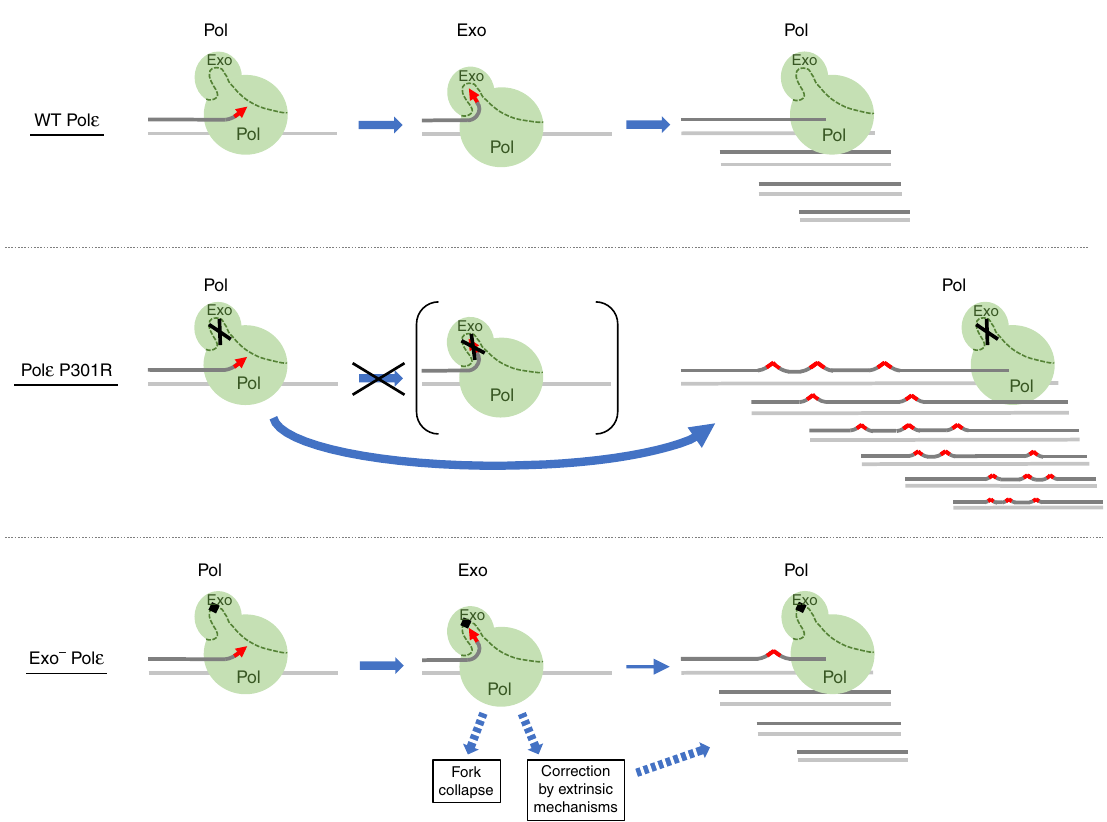
Fig. 6 Pol ε exonuclease domain alterations as a source of increased DNA polymerase activity and ultramutation in cancers. Synthesis by both wild-type Pol ε and exo − Pol ε involves partitioning of the primer terminus between the polymerase (Pol) and exonuclease (Exo) active sites. This partitioning limits the rate of DNA synthesis and prevents ef fi cient mismatch extension, leading to the correction of errors by the intrinsic (wild-type Pol ε ) or extrinsic (exo − Pol ε ) mechanisms. In contrast, the cancer-associated P301R substitution restricts access of the primer terminus to the exonuclease site, prompting the polymerase to stay in the elongation mode and, thus, resulting in hyperactivity and a high mutation